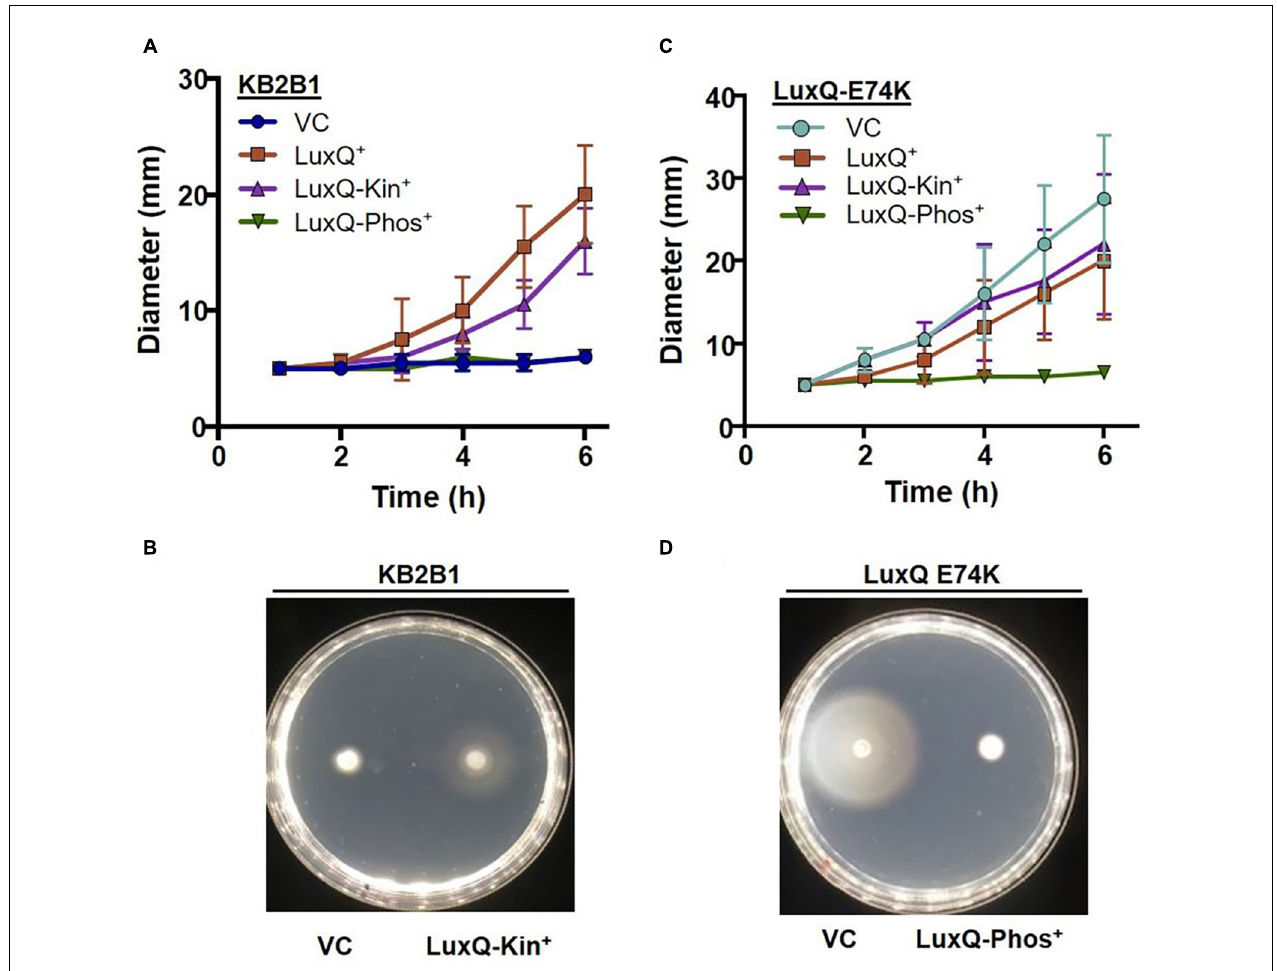
FIGURE 5 | Motility of KB2B1 expressing LuxQ variants. Migration on TBS-Mg 2 + agar of (A,B) KB2B1 or (C,D) KV8961 ( luxQ -E74K) carrying vector control (VC) pVSV105 or plasmids expressing ES114 wild-type LuxQ (LuxQ + ) (pVAR48) or variants of ES114 LuxQ with activity that is kinase-only (LuxQ-Kin + ) (pVAR50) or phosphatase-only (LuxQ-Phos + ). Time courses are shown in panels (A,C) , while representative images are shown in panels (B,D)